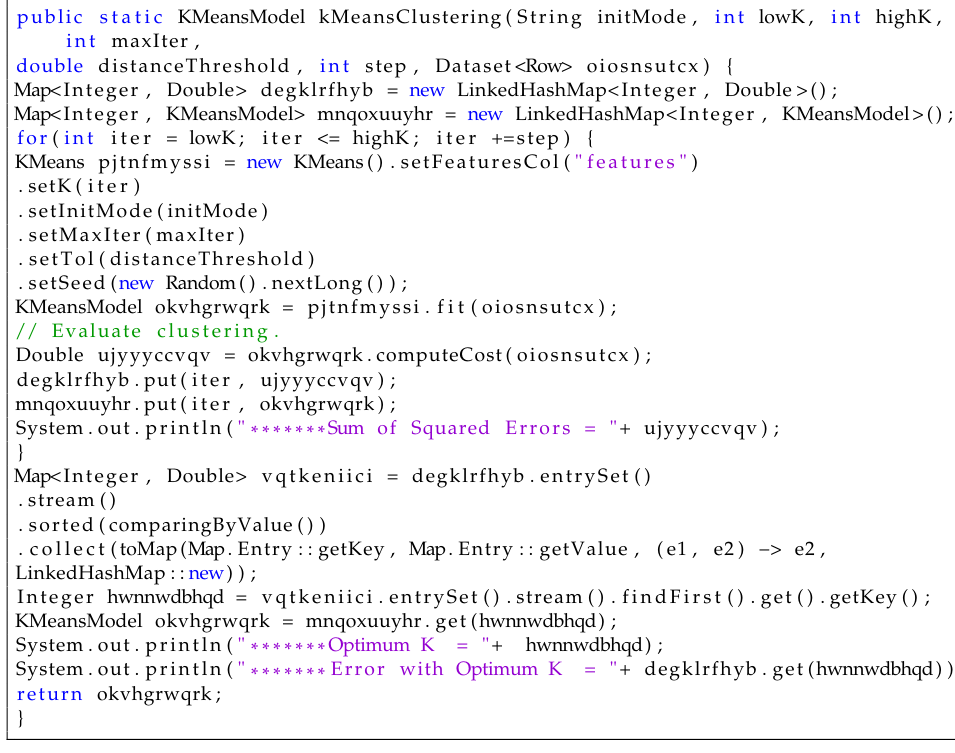
Listing 3: Function generated for applying KMeans